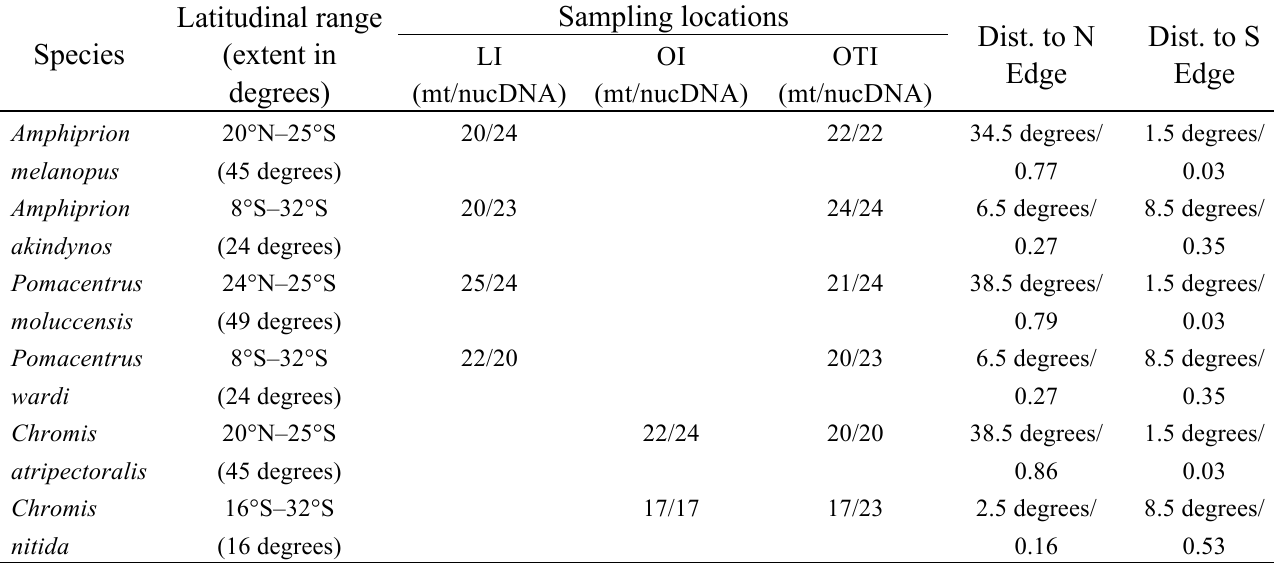
Table 1. Latitudinal extent of geographical range, sampling locations and sizes for (mtDNA/nucDNA) analyses, distance from sampling locations to the northern (N) and southern (S) range margins (degrees of latitude and proportion of total range). LI = Lizard Island, OI = Orpheus Island, OTI = One Tree